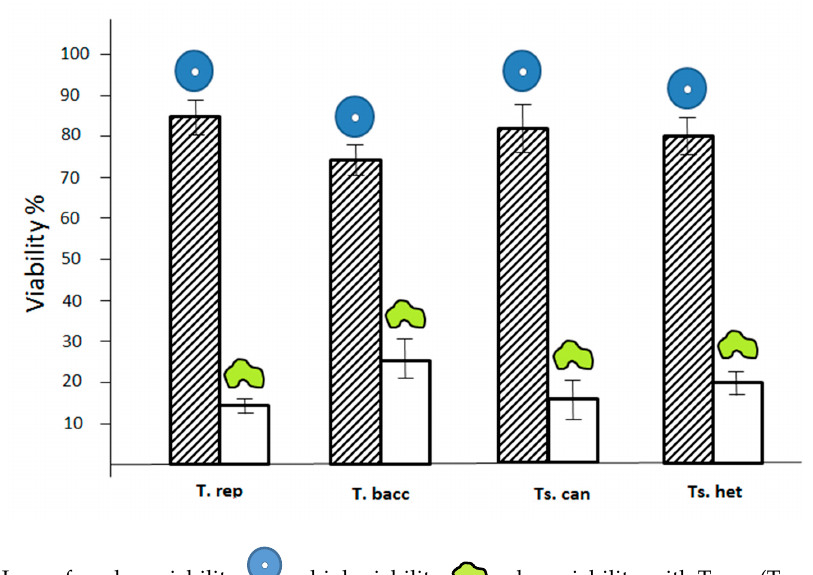
Figure 2. Loss of nuclear viability = high viability = low viability with T. rep (Taxus repens), T. bacc (Taxus baccata), Ts. can (Tsuga cannadensis) and Ts. het (Tsuga heterophilla).